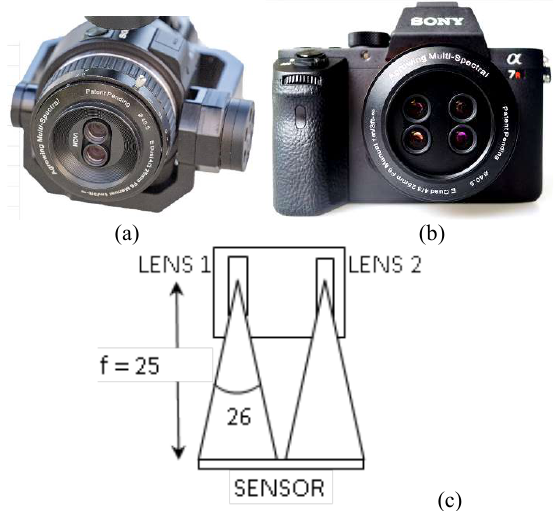
Figure 1. Multispectral cameras with: (a) two heads and (b) four heads (c) diagram for the dual head